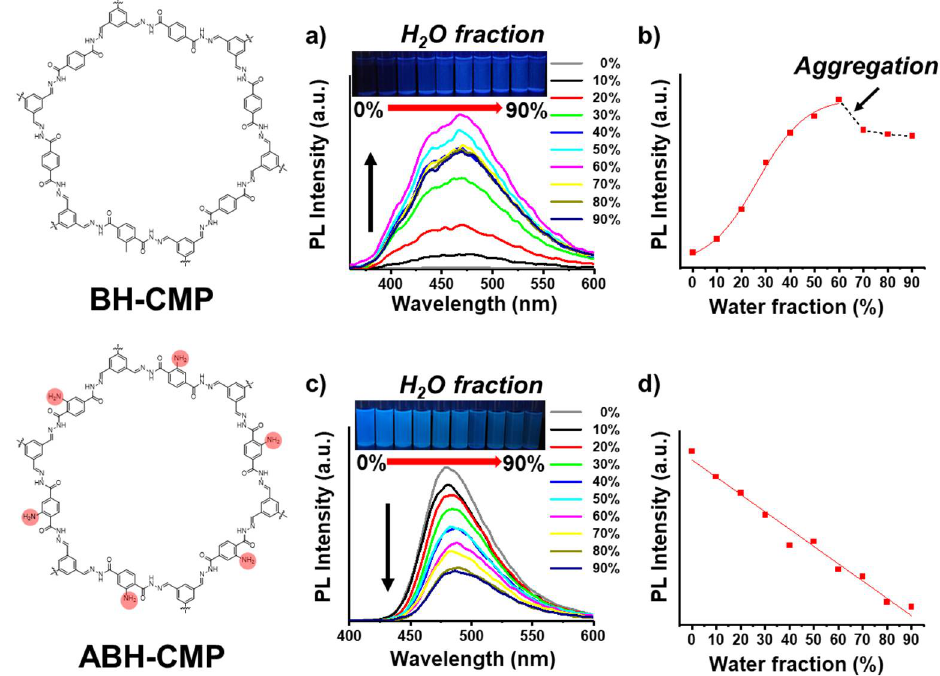
Figure 1. Photoluminescence (PL) emission spectra of ( a ) BH-CMP and ( c ) ABH-CMP in a water/DMF dispersion (1.0 mg/mL, water/DMF ratios of 0:10–9:1) (inset: images of BH-CMP and ABH-CMP under a 365 nm ultraviolet lamp). Plots of the PL intensity of ( b ) BH-CMP and ( d ) ABH-CMP versus the water fraction in a water/DMF